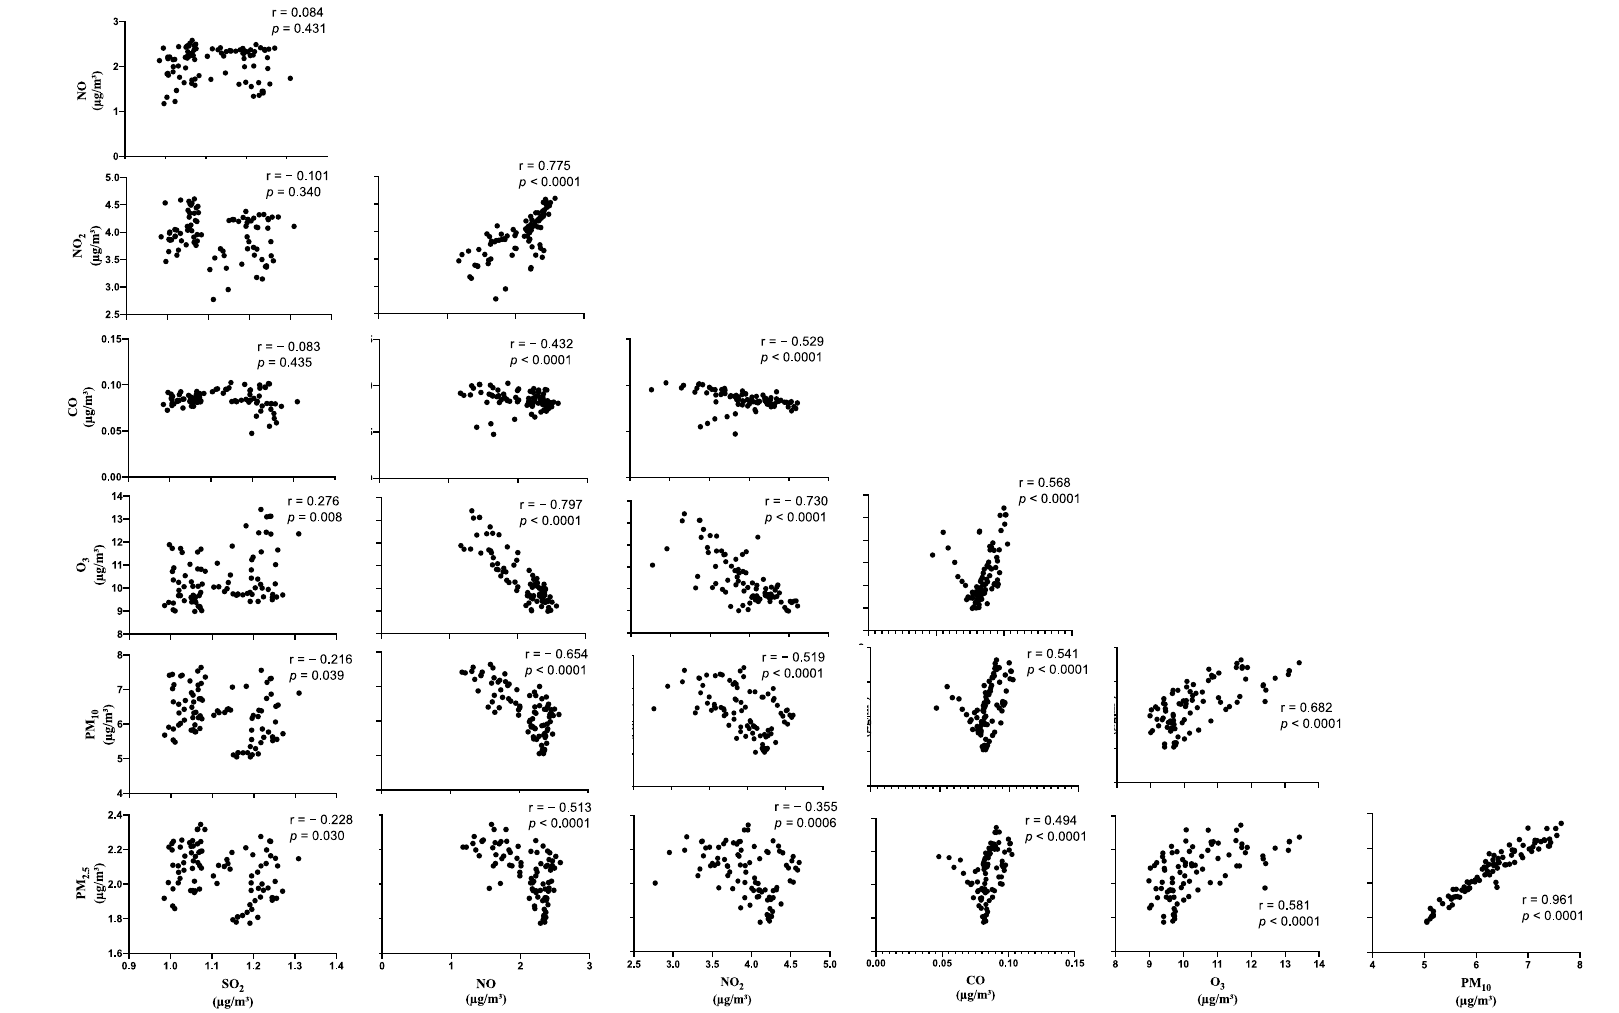
Figure 1. Correlation plots between SO 2 , NO, NO 2 , CO, O 3 , PM 10 , and PM 2.5. Air pollutant levels are represented as the mean daily level across pregnancy from hourly measurements. Each air pollutant was normalized as a quotient of the hourly temperature and humidity at the time of collection.